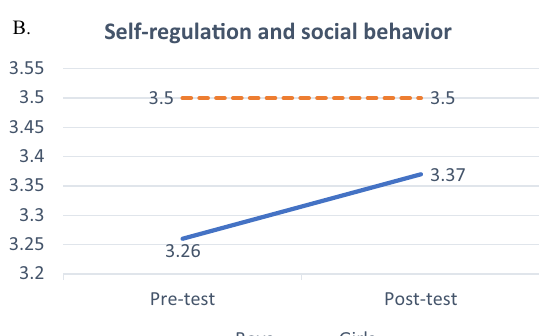
Fig. 3 Effects on the STEAM program using robotic kits by gender. A Interaction effects between gender and CT measured using the TACTIC–KIBO. B Interaction effects between gender and self-regulation and social